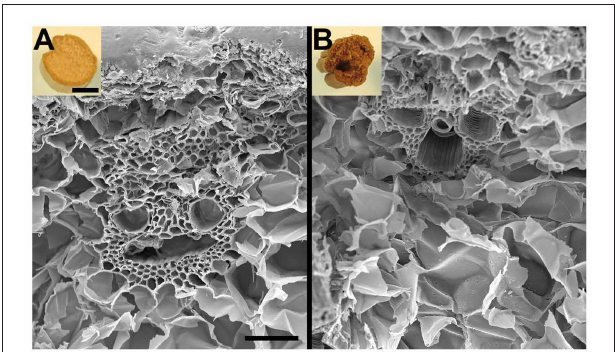
FIGURE 3 | Pictures of untreated (A) and EA pretreated (B) of corn stover stems along with their scanning electron microscopy (SEM) images. SEM revealed no perceptible modification of cell walls, except distorted cell structures were observed after pretreatment. Bar = 1cm inlets and 100 µ m for SEM images.